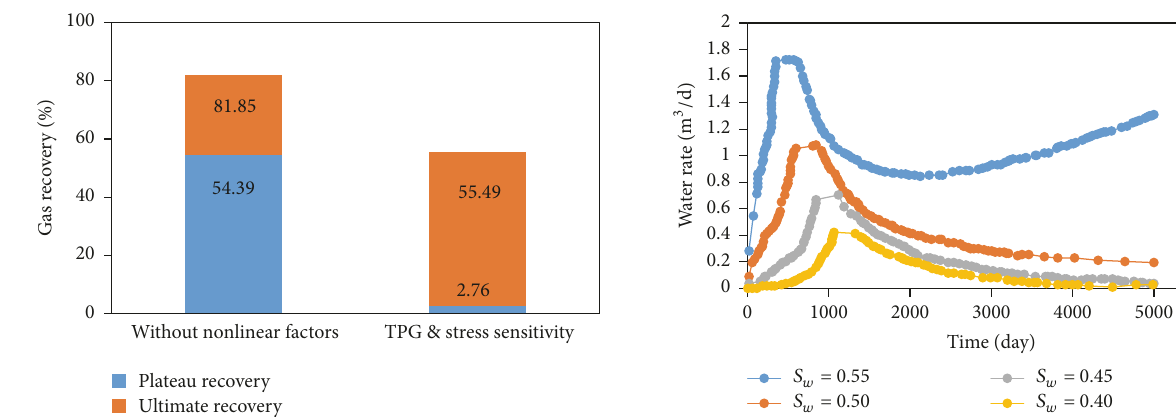
Figure 15: Gas recovery of different periods with or without TPG and stress sensitivity.